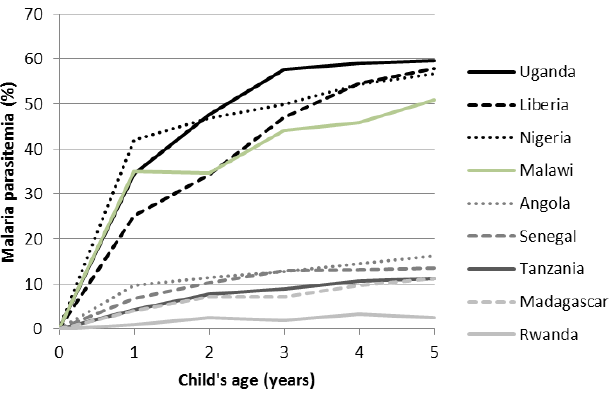
Fig. 3 . Prevalence of malaria parasitemia by child's age and